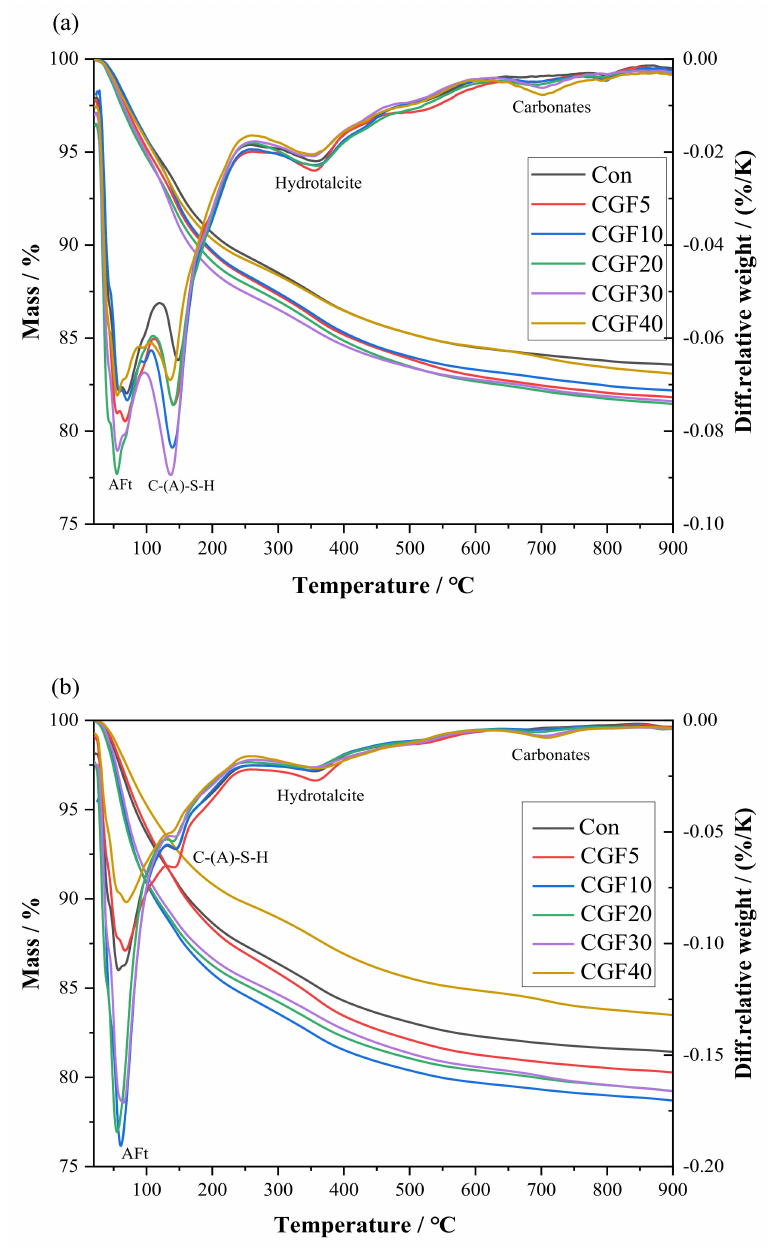
Figure 3. TGA-DTG curves of AAC: ( a ) 3 d and ( b ) 28